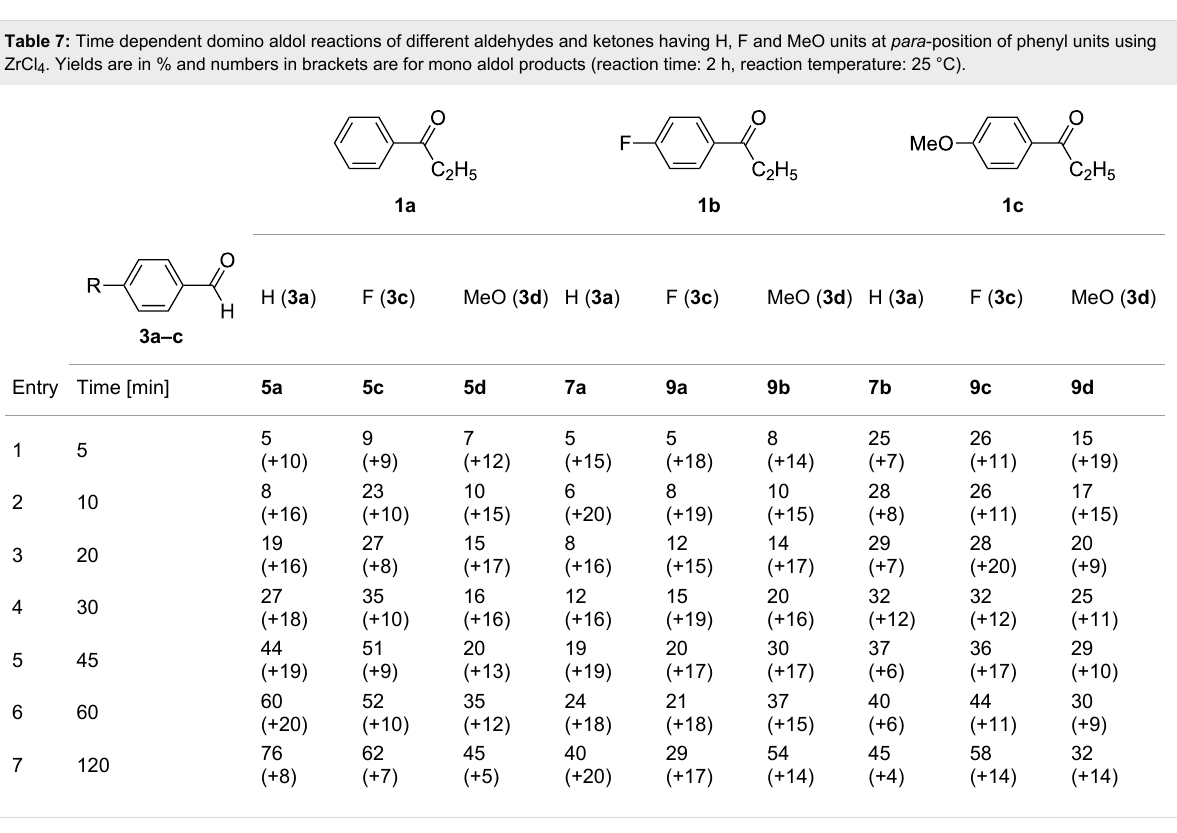
Table 8: Reaction of benzaldehyde ( 3a ) with indium propiophenone enolate in the CYTOS TM Labsystem ( 5a / 6a in %).